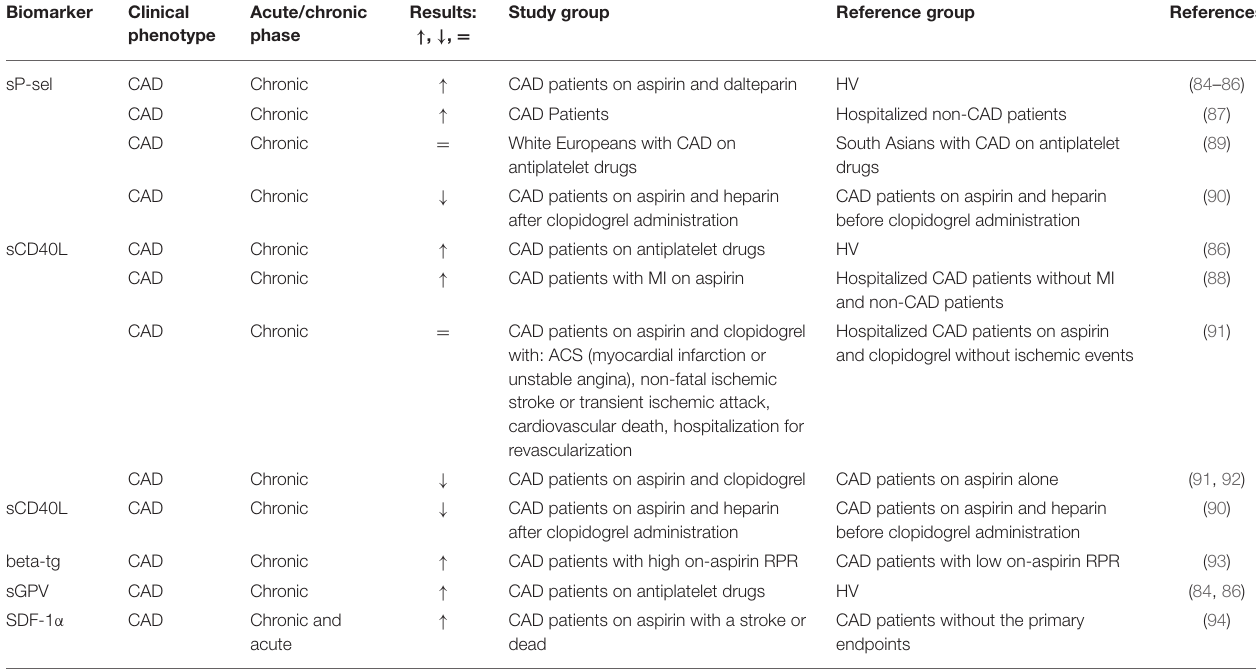
TABLE 1 | Soluble biomarkers of platelet activation in coronary artery disease (CAD)